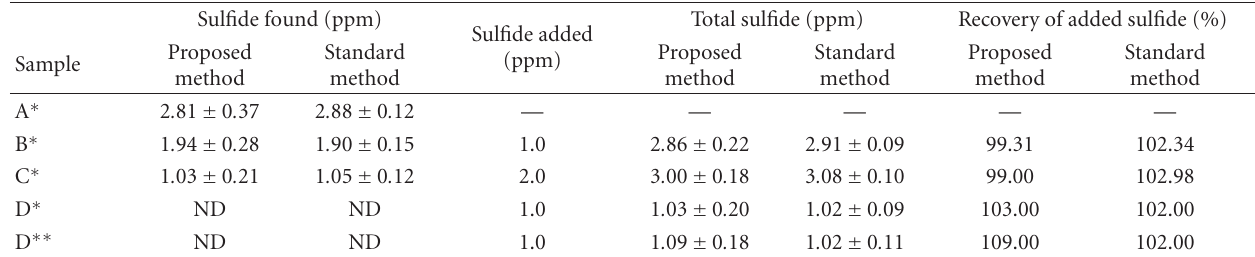
Table 3: Determination of dissolved sulfide from leachate samples.